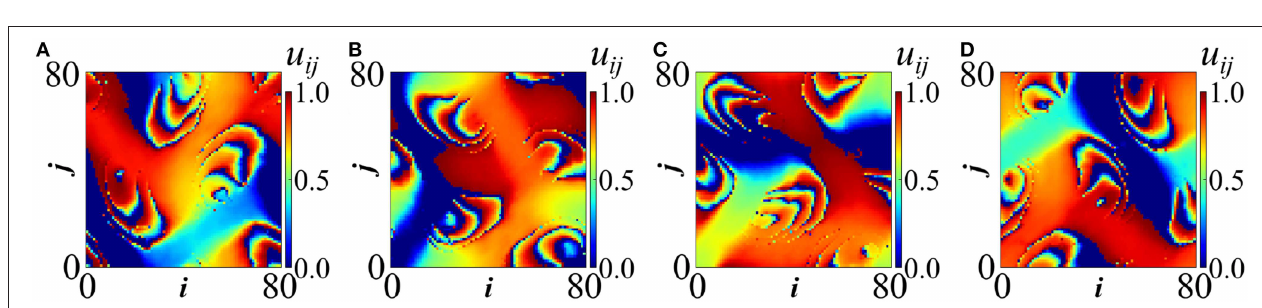
FIGURE 7 | Spiral wave chimeras around a coherent core for random hierarchical connectivity in LIF model; potential profiles are depicted at four instances: (A) t = 3300 (B) t = 3360 (C) t = 3420 and (D) t = 3480 (in time units). Parameters are σ = 0.22 and T r = 0.6. All other parameters are as in Figure 2A . Simulations start from random initial conditions. A related video is included in the Supplementary Material